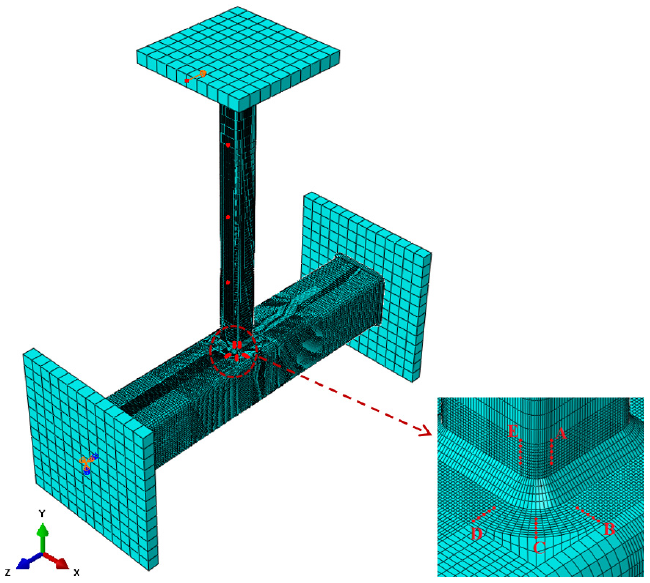
Figure 5. Stress − strain relationship used in the FEA simulation: ( a ) Concrete and ( b ) Steel.